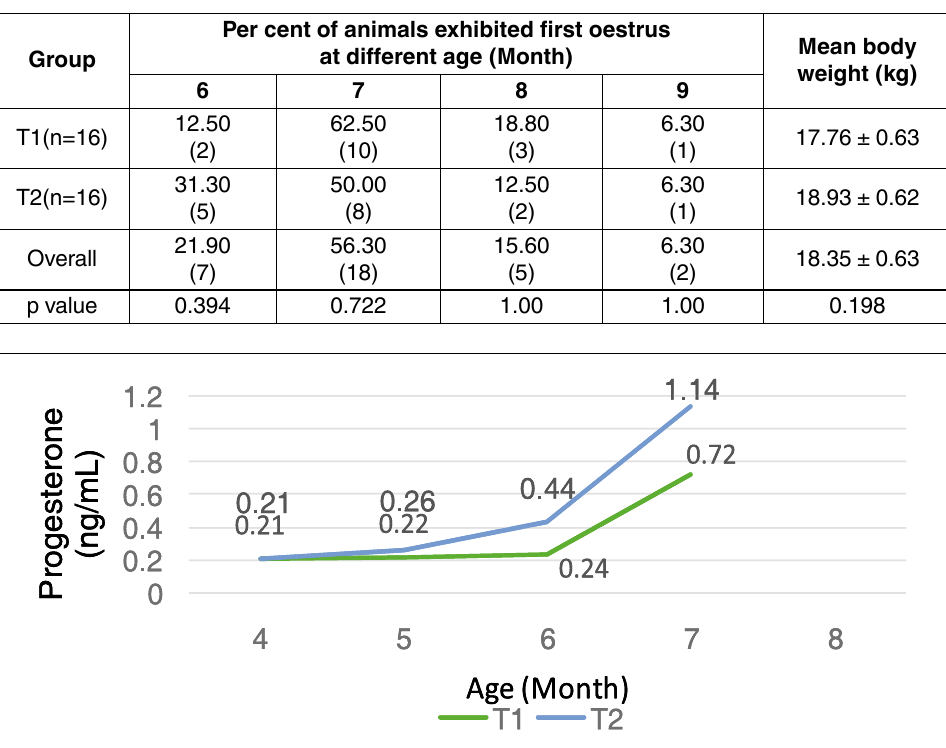
Table 5. Age (Months) and mean body weight (kg) at first observed oestrus in control and experimental groups Group